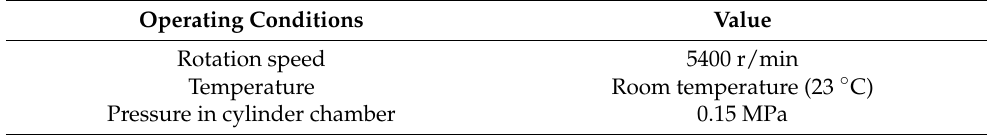
Table 5. Operating conditions of the degradation test.